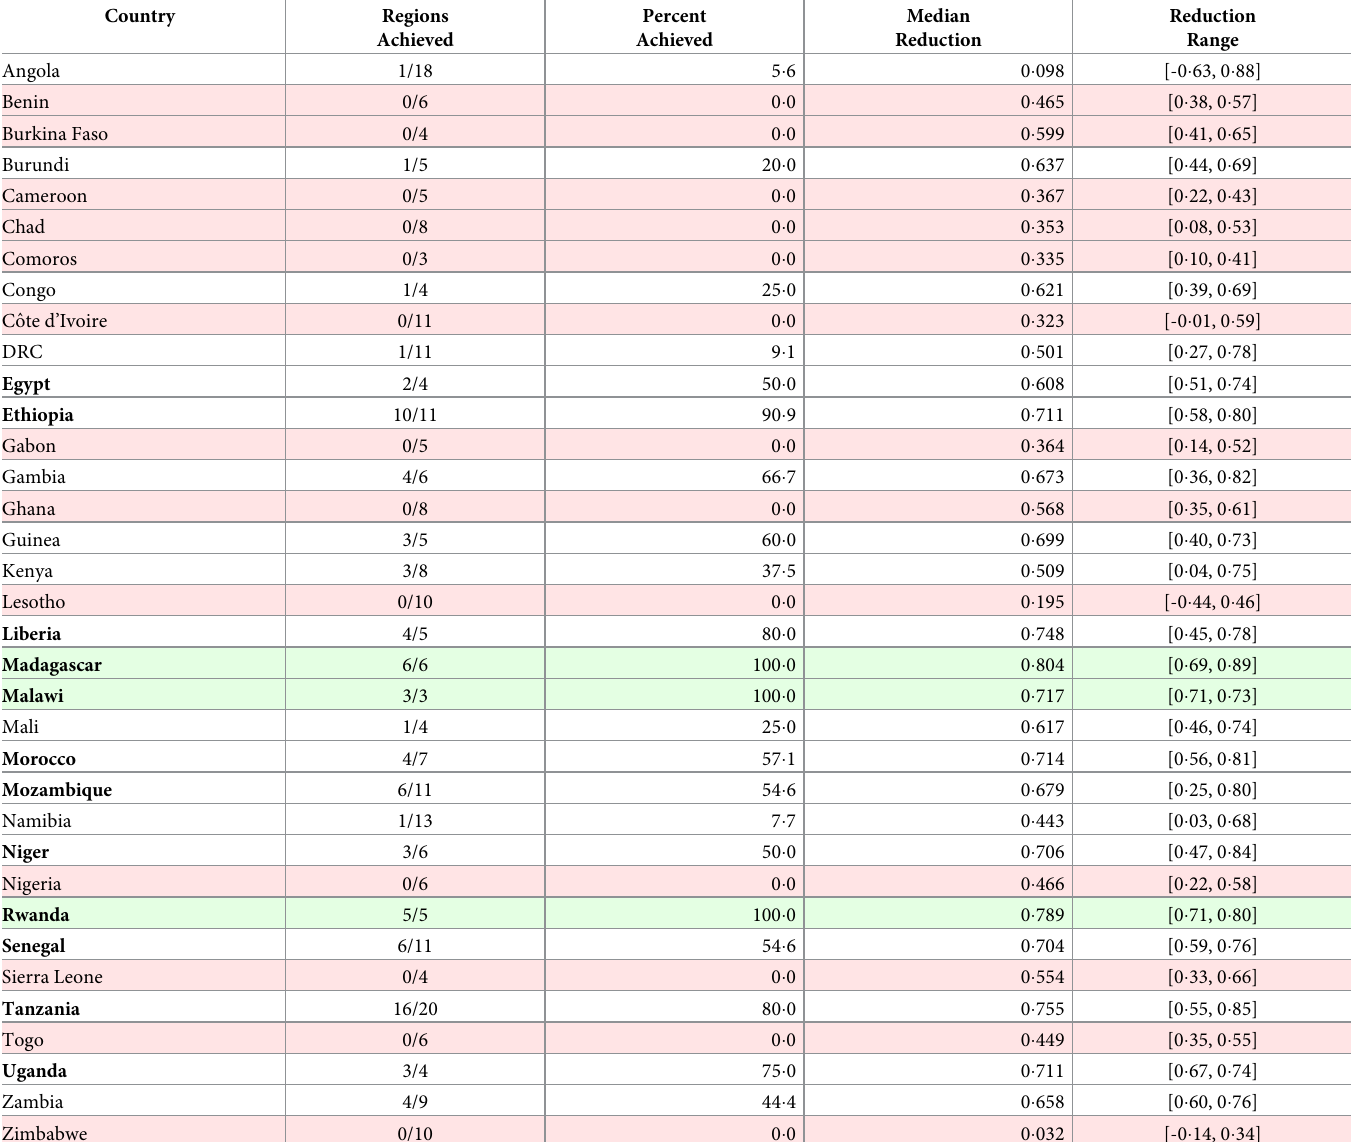
Table 2. Subnational MDG 4 target achievement.